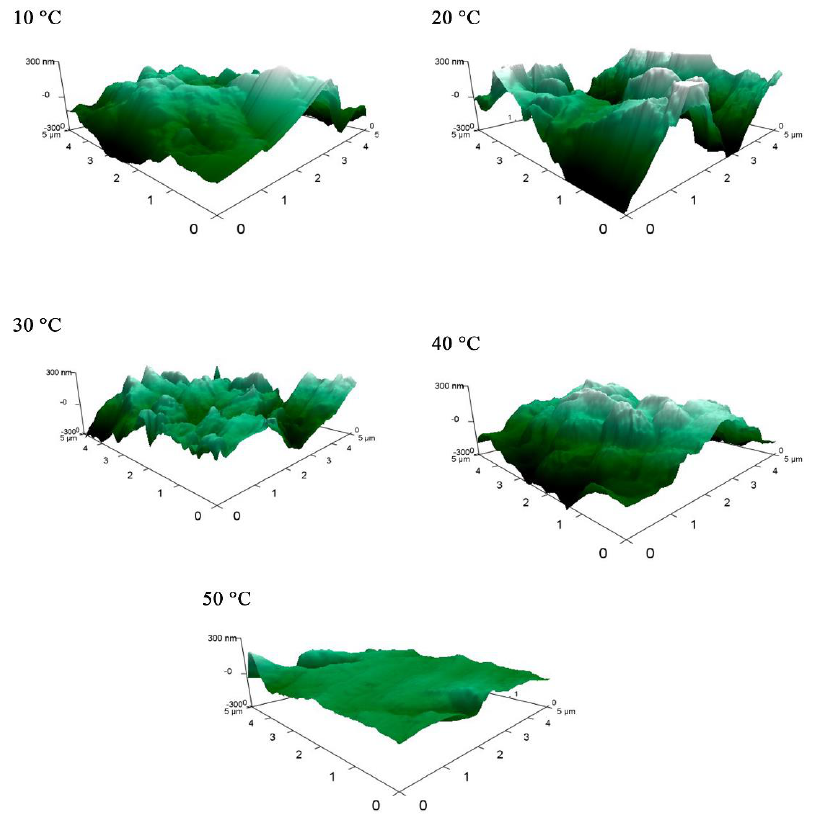
Figure 3. Three-dimensional atomic force microscope (AFM) figures of composite anodic films at different temperatures.